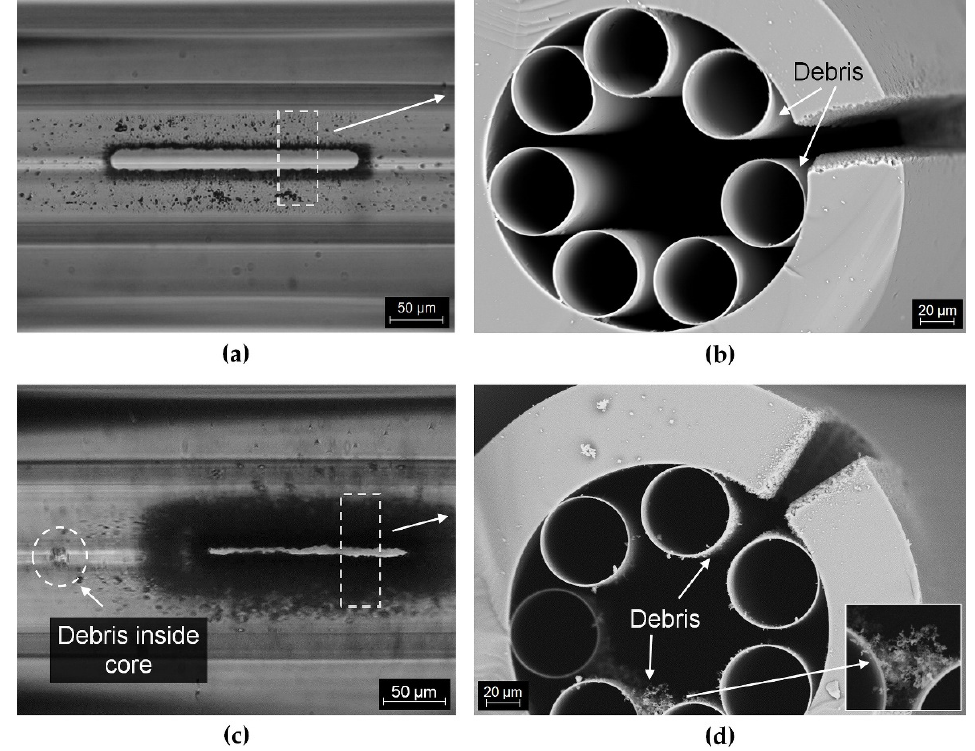
Figure 8. Images of microchannels processed in the ARHCF: ( a ) using an aspherical lens, ( b ) SEM cross-sectional image with debris in the vicinity of the microchannel made using an aspherical lens, ( c ) using the F-theta lens, and ( d ) SEM cross-sectional images with debris in the vicinity of the microchannel made with the F-theta lens.